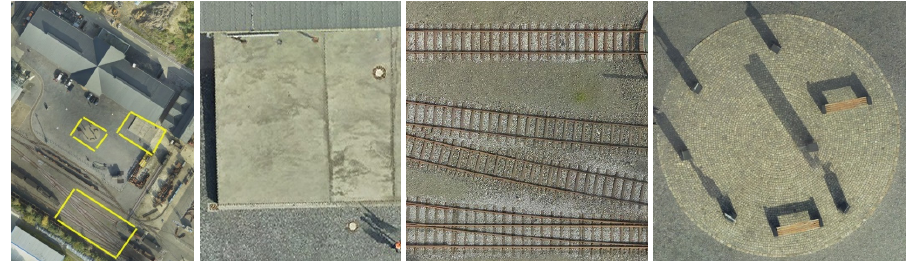
Figure 11. Overview of area-based objects (left) and detailed view (f.l.t.r.): ramp, rails and paving stones